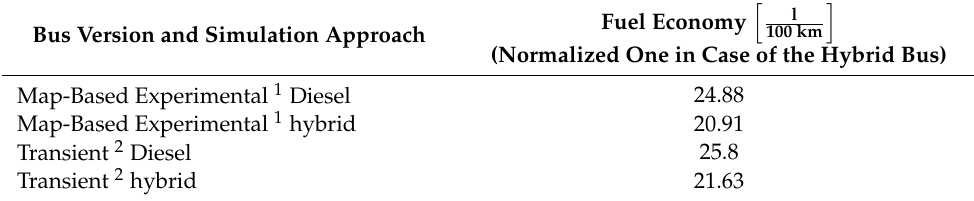
Table 5. WHVC: Fuel economy for Diesel and hybrid bus